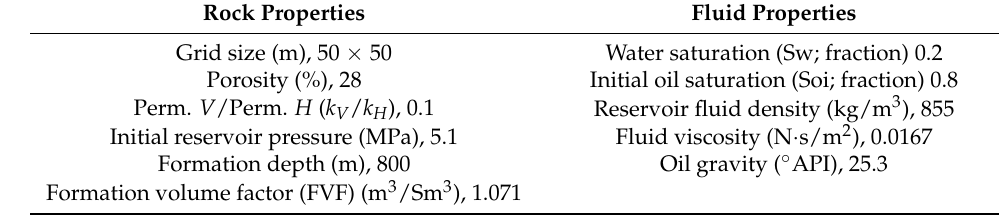
Table 5. Petrophysical and fluid properties of the reservoir rock.